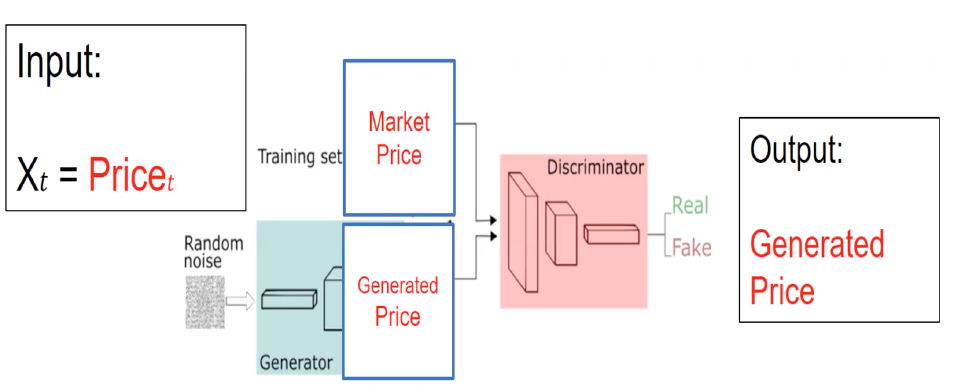
Figure 1. Given the original market prices as input, we trained the datasets using WGAN-GP and output the generated real and fake prices judged by the discriminators. The generator struggles to trick the Discriminator, while the Discriminator criticizes the generator until approaching equilibrium, keeping the training process as a zero-sum game in Algorithm